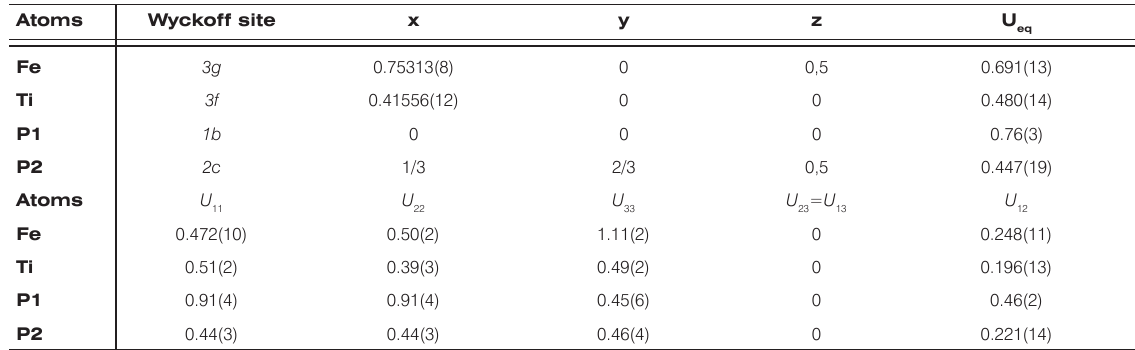
Table 4. Atomic and thermal (nm 2 ) parameters for TiFe Р (from X-ray single crystal diffraction data).